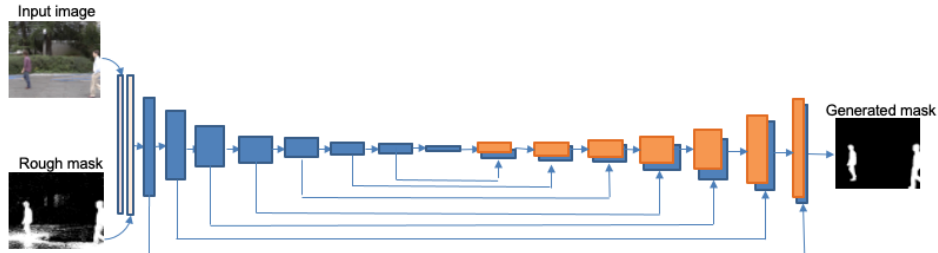
Figure 3. Scheme of the